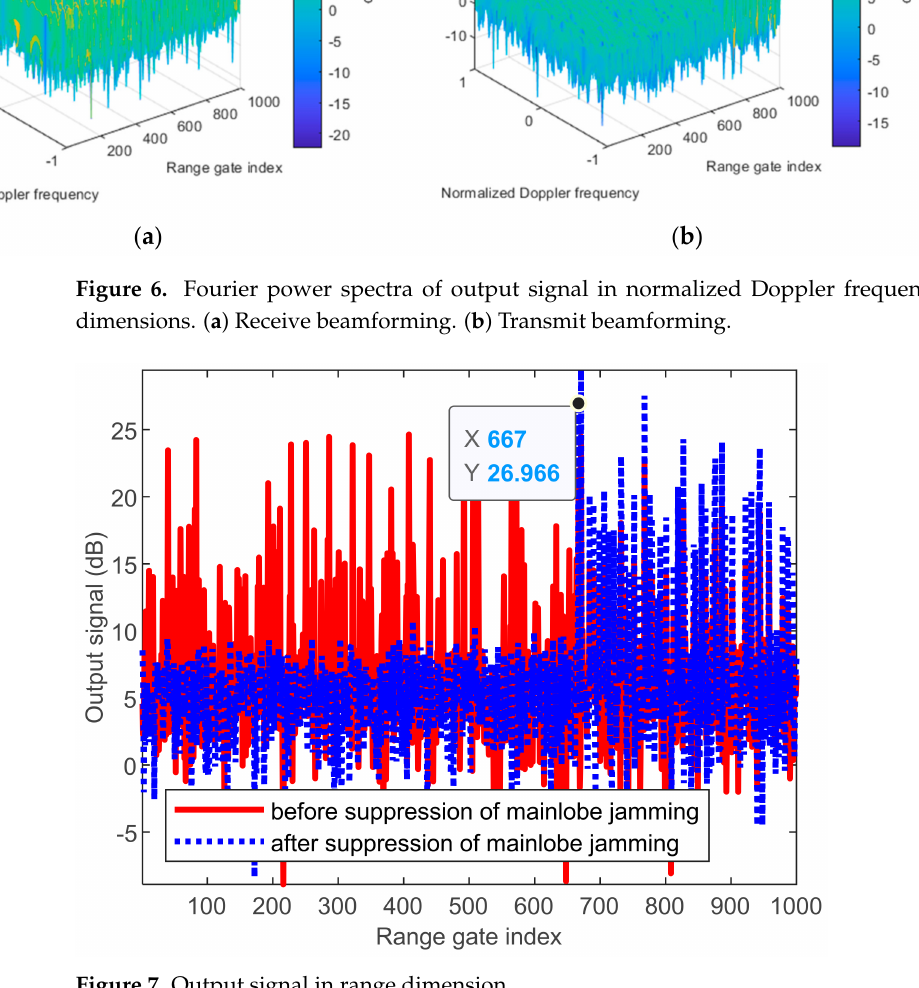
Figure 7. Output signal in range